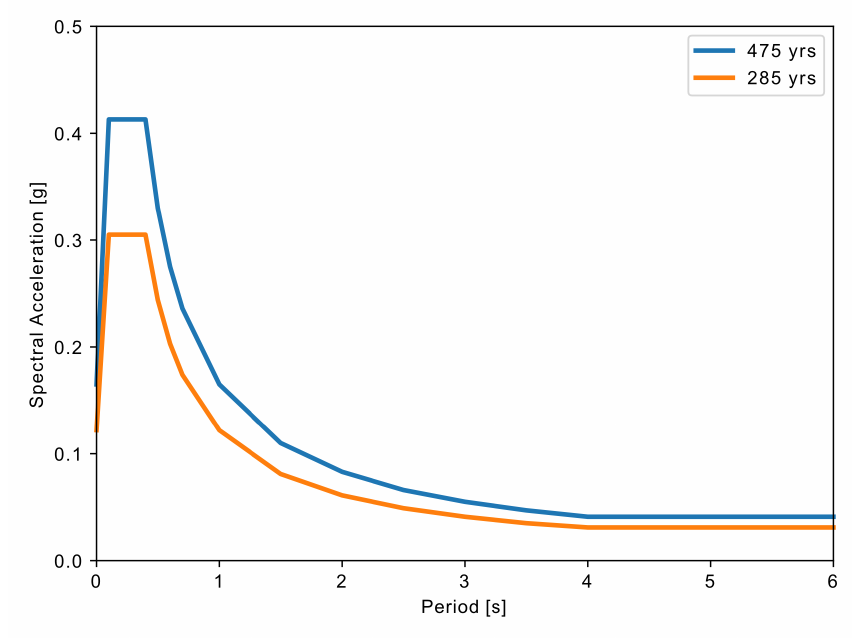
Figure A3. Design response spectra for offshore sites in Gujurat obtained from the PSHA shown in Figure A2 for return periods 475 years and 285 years.